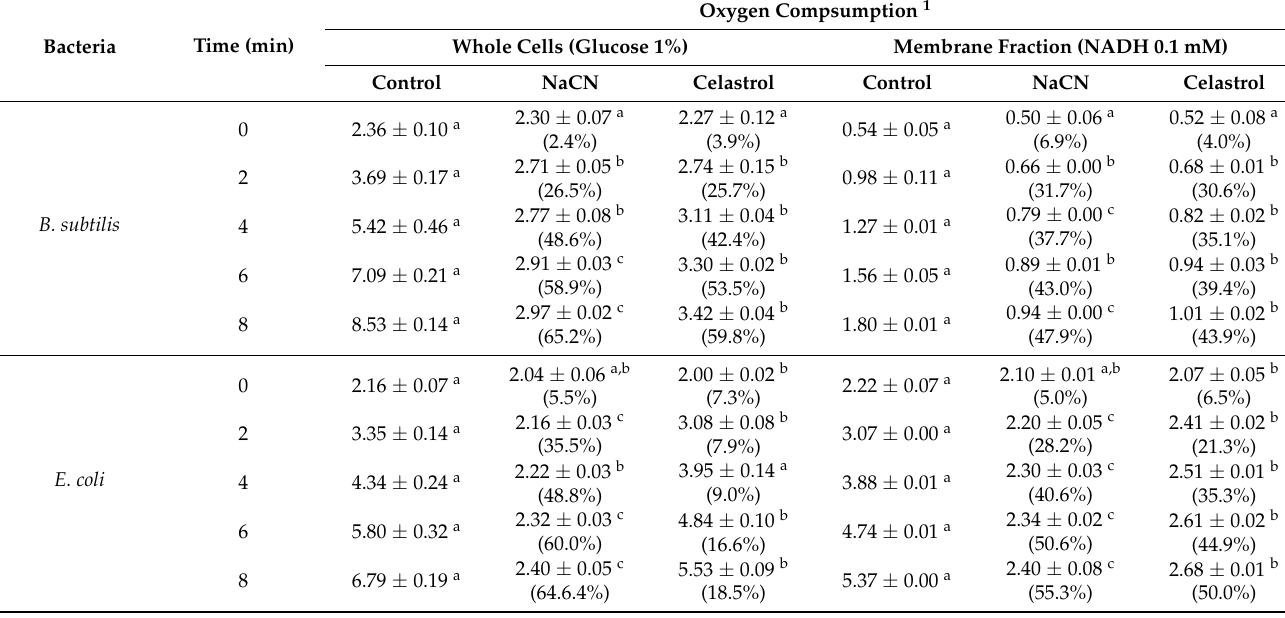
Table 3. Mean values ± standard deviations of means ( n = 3) of oxygen consumption rates ( µ L O 2 /min) at different times in whole cells or membrane preparations of B. subtilis and E. coli without treatment or after treatments with celastrol at 3 µ g/mL or sodium cyanide (NaCN) at 6.7 mM used as positive controls. The percentage (%) of inhibition in the oxygen consumption referring to the untreated cells (negative control) is shown in